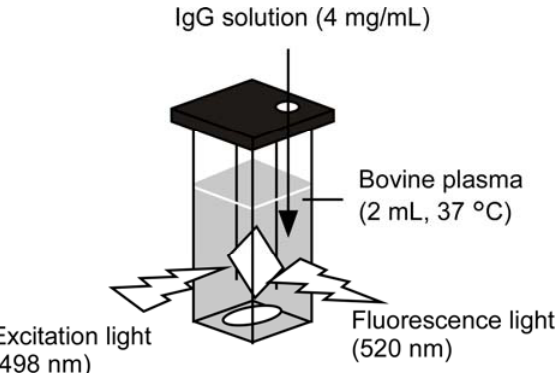
Figure 1. Experimental setup for measurement of fluorescence